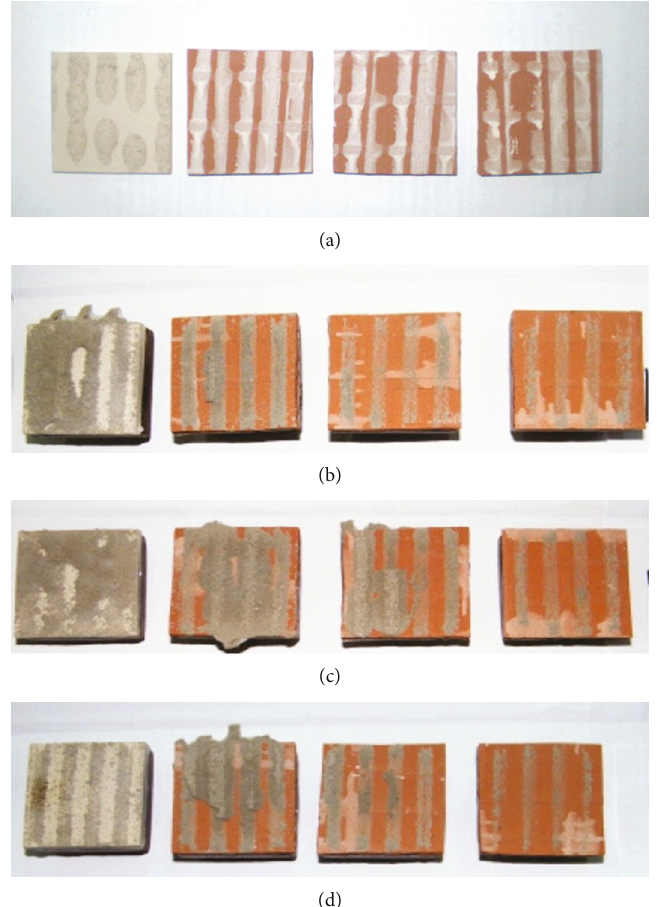
Figure 7: Surface of tiles from the installation site after detachment. From left: initial adhesion, open time 10 min, 20 min, and 30min. Adhesives: (a) without methylcellulose, (b) with methylcellulose of 11 – 18 Pas viscosity, (c) with methylcellulose of 35 – 45 Pas viscosity, and (d) with methylcellulose of 65 – 75Pas viscosity